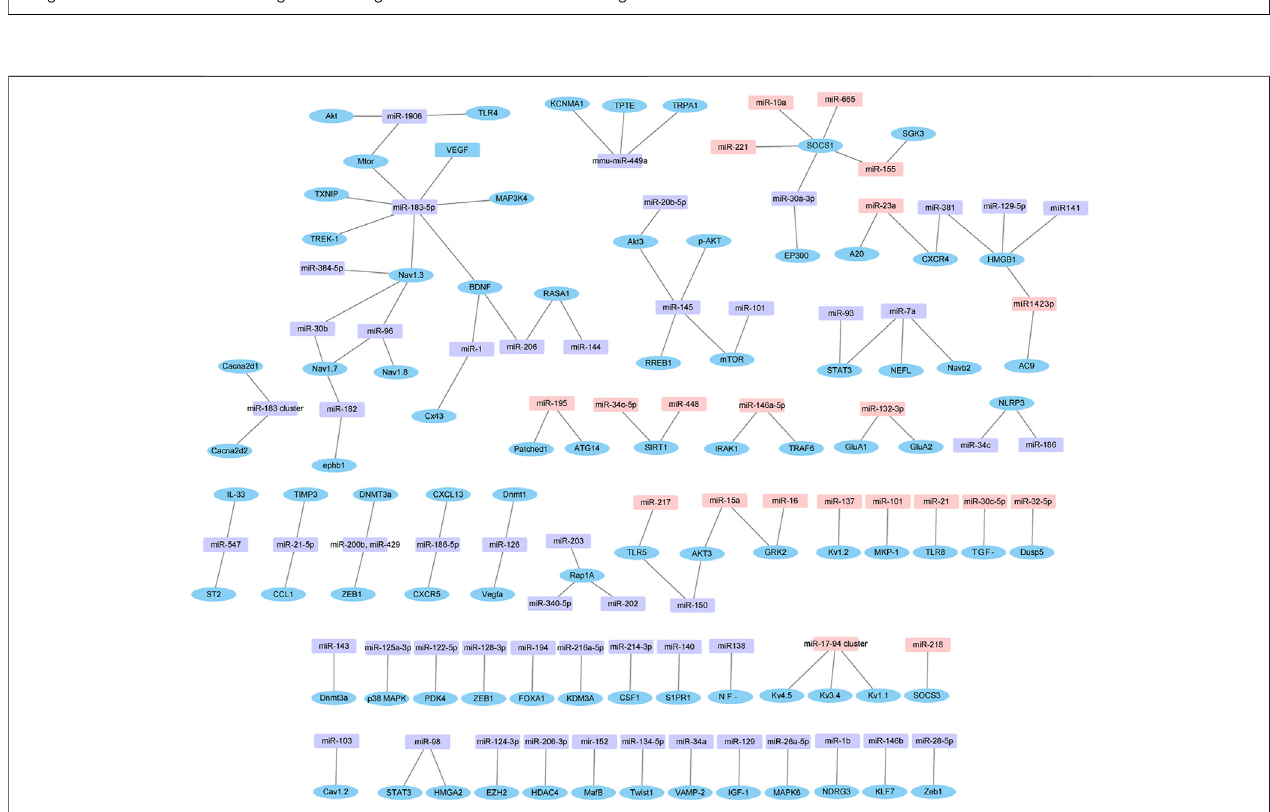
FIGURE7| DysregulatedmiRNAs-targetgenenetwork.ThenetworkisbasedondysregulatedmiRNAsandtheirtargetgenesidenti fi edin SupplementaryTable S4 . Pink in rectangle represent up-regulated miRNAs, purple in rectangle represent down-regulated miRNAs, and blue in ellipse represent target genes.